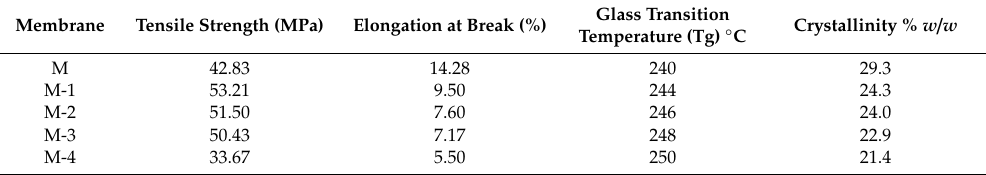
Figure 2. Wide-angle X-ray diffraction patterns of crosslinked sodium alginate and related nanocomposite membranes. M: 0%, M-1: 10%, M-2: 20%, M-3: 30%, and M-4: 40% titanium dioxide (all % w / w ). Table 1. Mechanical properties, Tg, and crystallinity values of crosslinked NaAlg and its TiO 2 incorporated composite